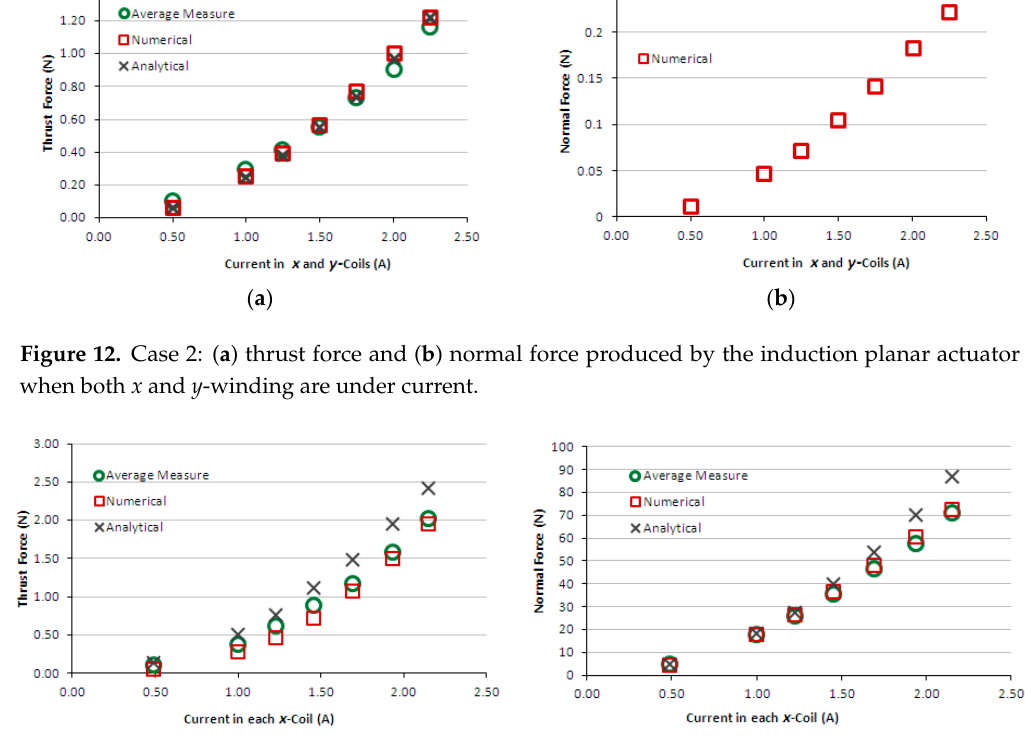
( b ) Figure 14. Case 3: ( a ) thrust force and ( b ) normal force produced by the induction planar actuator when both x and y -winding are under current. In all graphs, analytical calculations of the components of the magnetic flux density and forces were performed considering n and m harmonics up to the 499th order. For comparison and validation of the results, figures are obtained by the numerical and analytical models and by measurements under the same conditions of current. 6. Discussion and Conclusions The induction planar actuator has potential in terms of application to the inspection of inclined ferromagnetic surfaces, such as ship hulls, tanks, pipelines and other sorts of metallic surfaces. Other systems already use magnetic attractive force to keep the device attached to the hull or other ferrous plates. The large normal force produced is highly advantageous and it allows keeping the device attached to the surface. The planar motion produced from only one device reduces the need for several actuators for orthogonal motion which decreases the weight and size of the system. In terms of inspection of non-ferromagnetic plates, the application of the actuator can be made in horizontal surfaces, since an adhesion force is not produced. In case 3, although an attraction force is present, the thrust force is not as high as that produced in case 1. The calculations and studies performed show that the thrust force produced by the induction planar actuator may be too small to move the inspection platform along heavily inclined surfaces, which could limit the application to the inspection of inclined ferromagnetic surfaces in the ascendant direction, allowing its utilization only when the movement is descendant. Another problem may be overcoming welds or strong roughness in the surface. A comparison of the magnitude of forces produced with the different secondaries as analysed shows that the best case occurs with the double layered secondary. In case 3, the lower conductivity of the steel causes a reduction of the thrust force, while in case 2, the lack of a low reluctance magnetic circuit in the secondary reduces the magnetic flux entering the secondary, as seen in